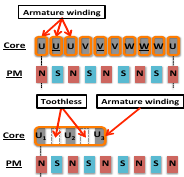
Figure 2: Tooth-less structure applied in the previous motor.